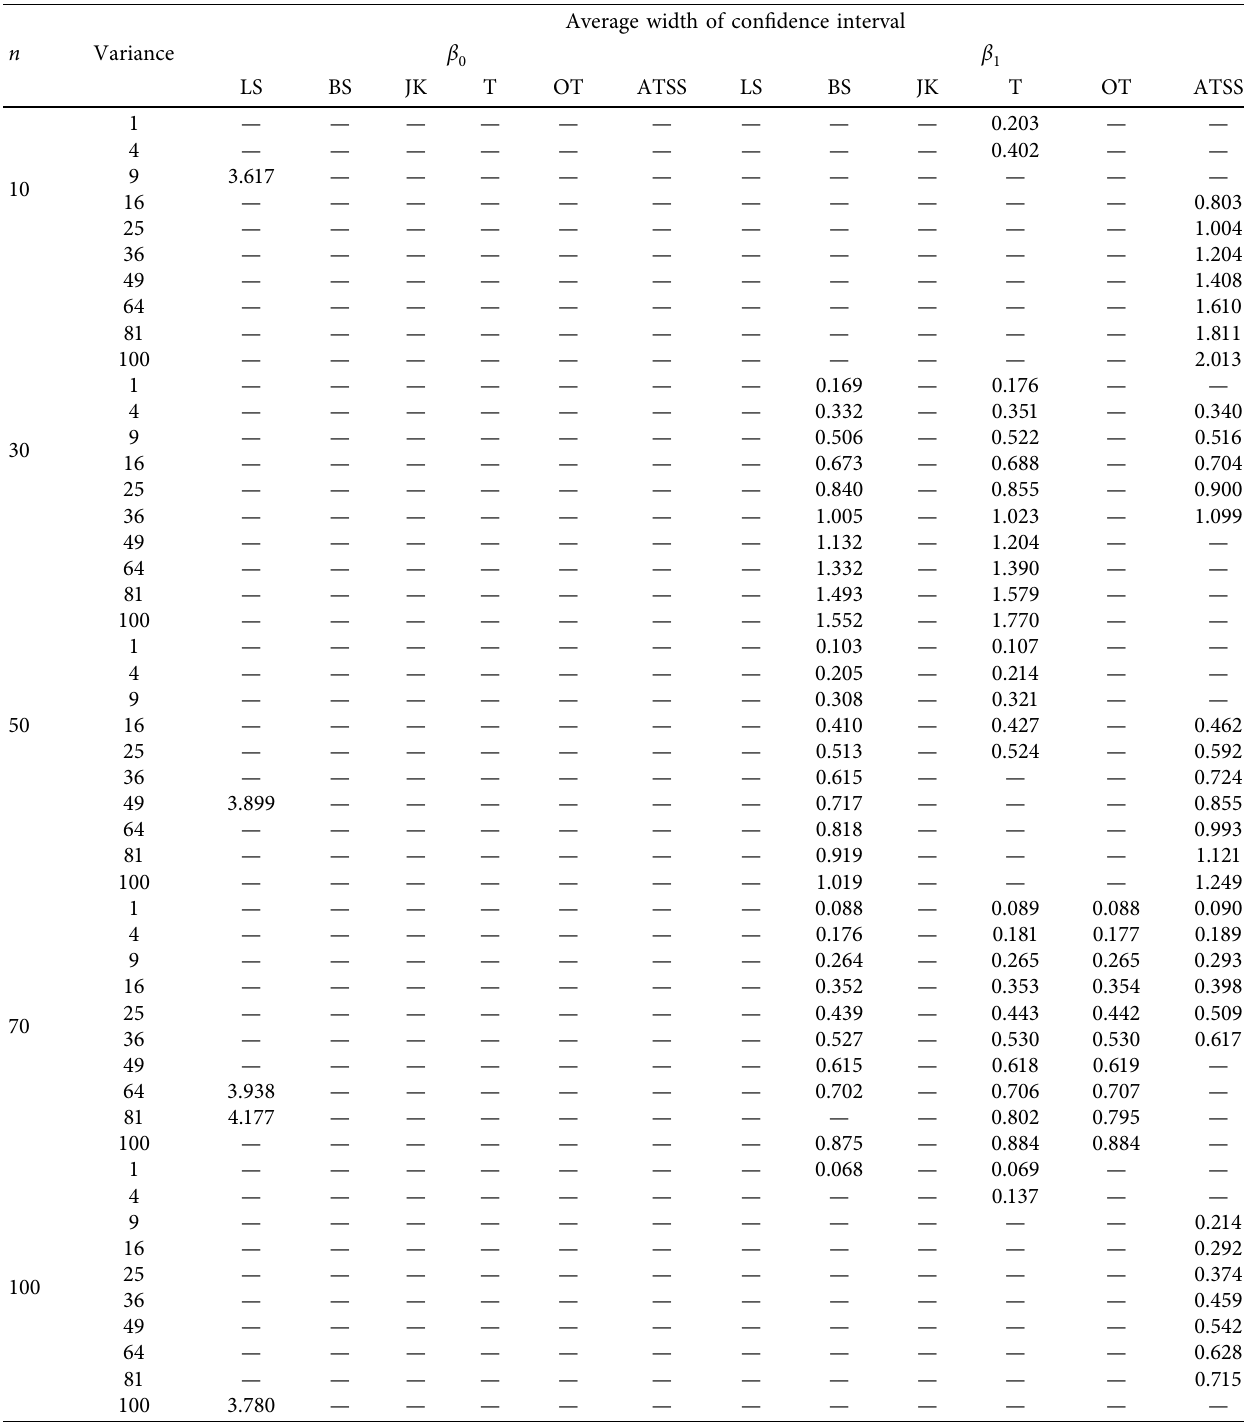
Table 4: The average width of the confidence interval for an independent variable has a scale-contaminated normal distribution with mean of 1 and variance of 1 and an error has a normal distribution with mean of 0 and variance of 1, 4, 9, 16, 25, 36, 49, 64, 81, and 100; sample sizes are 10, 30, 50, 70, 100, and 200.